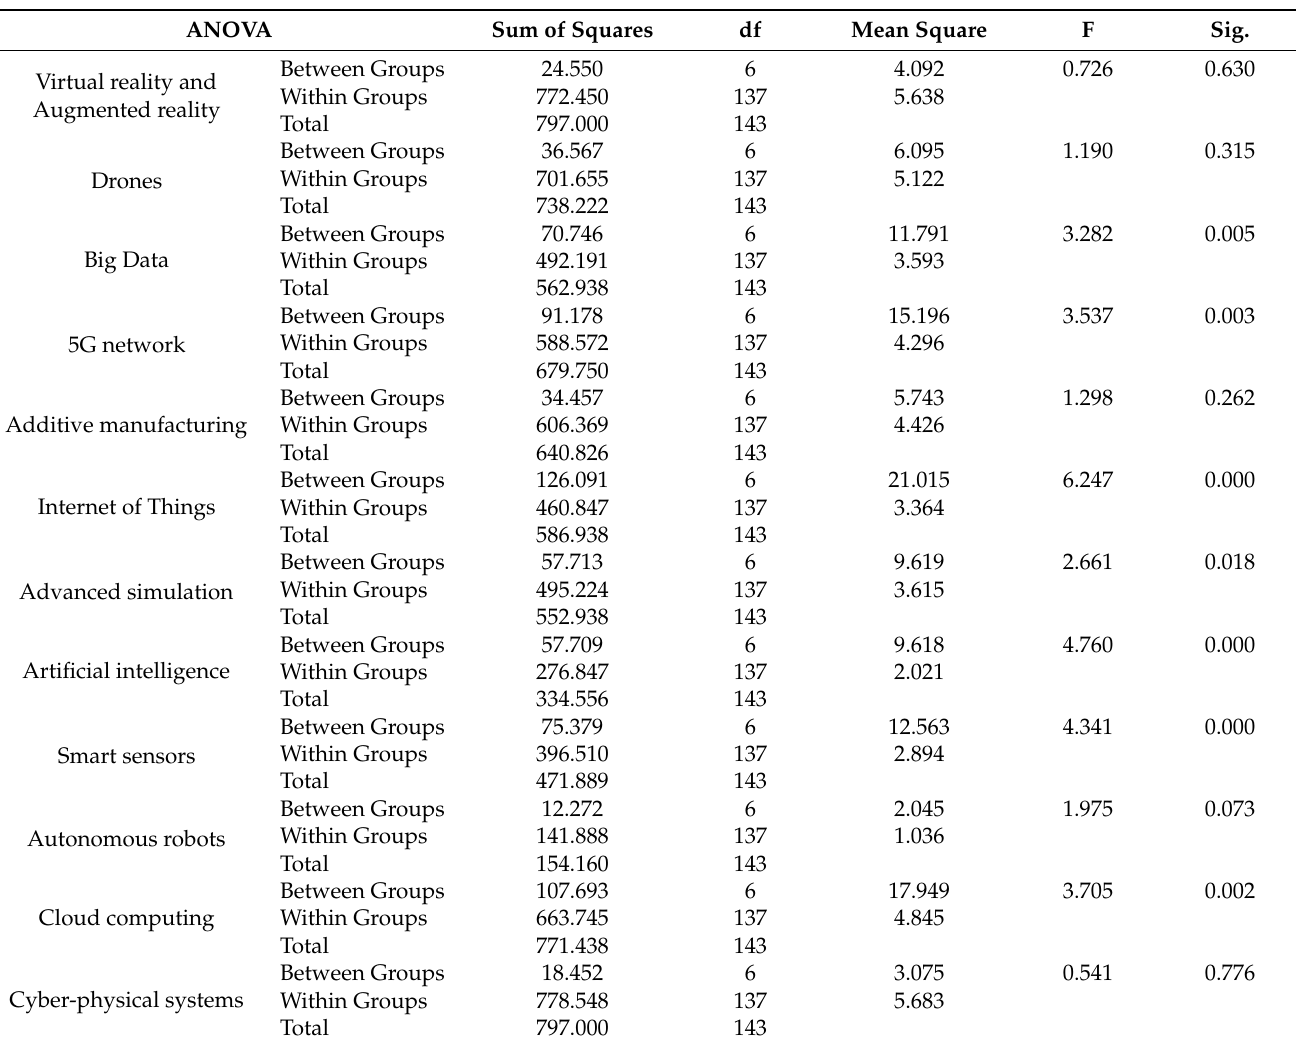
Table 8. Industry 4.0 technologies used in procurement logistics.